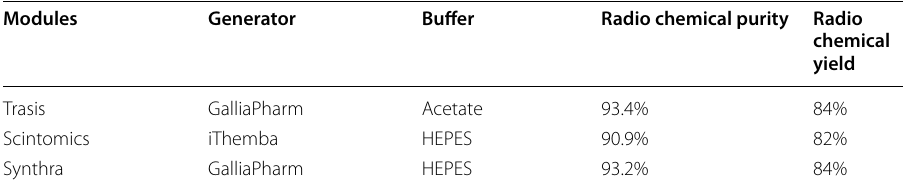
Legend: Syntheses conducted using the cassette and chemistry kit for labeling PSMA‑11 with 68 Ga at 95 °C for 10 min (n =